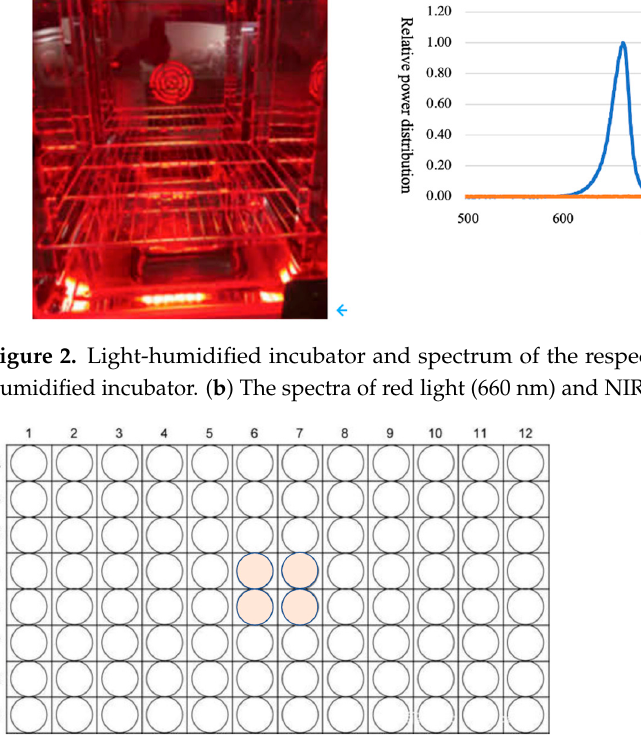
Figure 2. Light-humidified incubator and spectrum of the respective LED light source. ( a ) Light humidified incubator. ( b ) The spectra of red light (660 nm) and NIR light (850 nm) used in this study.